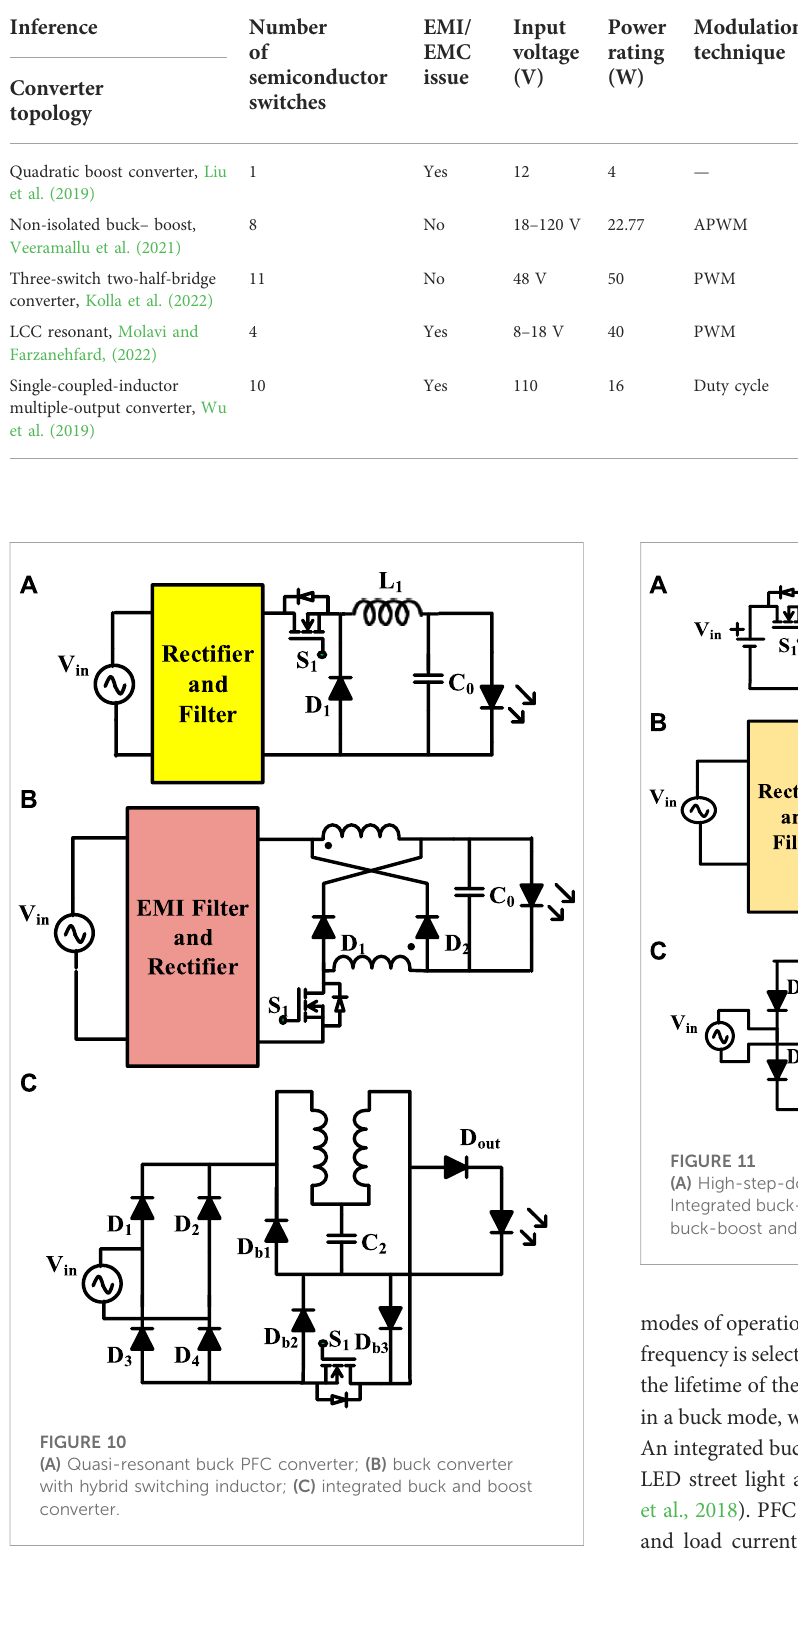
TABLE 3 Summary of various parameters of single-stage converter topologies fed LED isolated drivers.